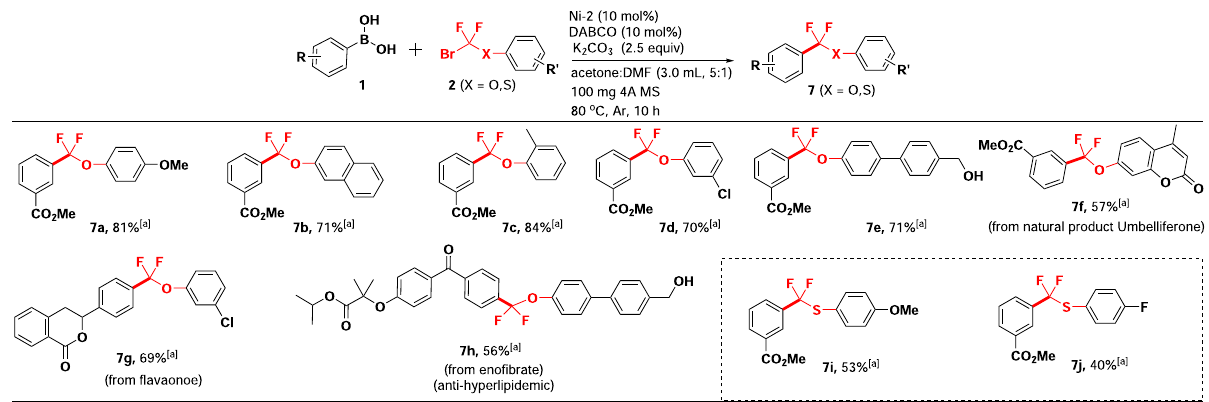
Fig. 3 Ni-catalyzed aryloxydi fl uoromethylation reactions with various di fl uoromethyl bromides. a Reaction conditions: unless otherwise noted, a solution of 1 (0.2 mmol), 2 (0.4 mmol), Ni-2 (10 mol%), DABCO (10 mol%), 100 mg 4 A MS and K 2 CO 3 (0.5 mmol) in dry acetone (2.5 mL) and DMF (0.5 mL) was performed at 80 o C under argon for 10 h. The yields are isolated yields.